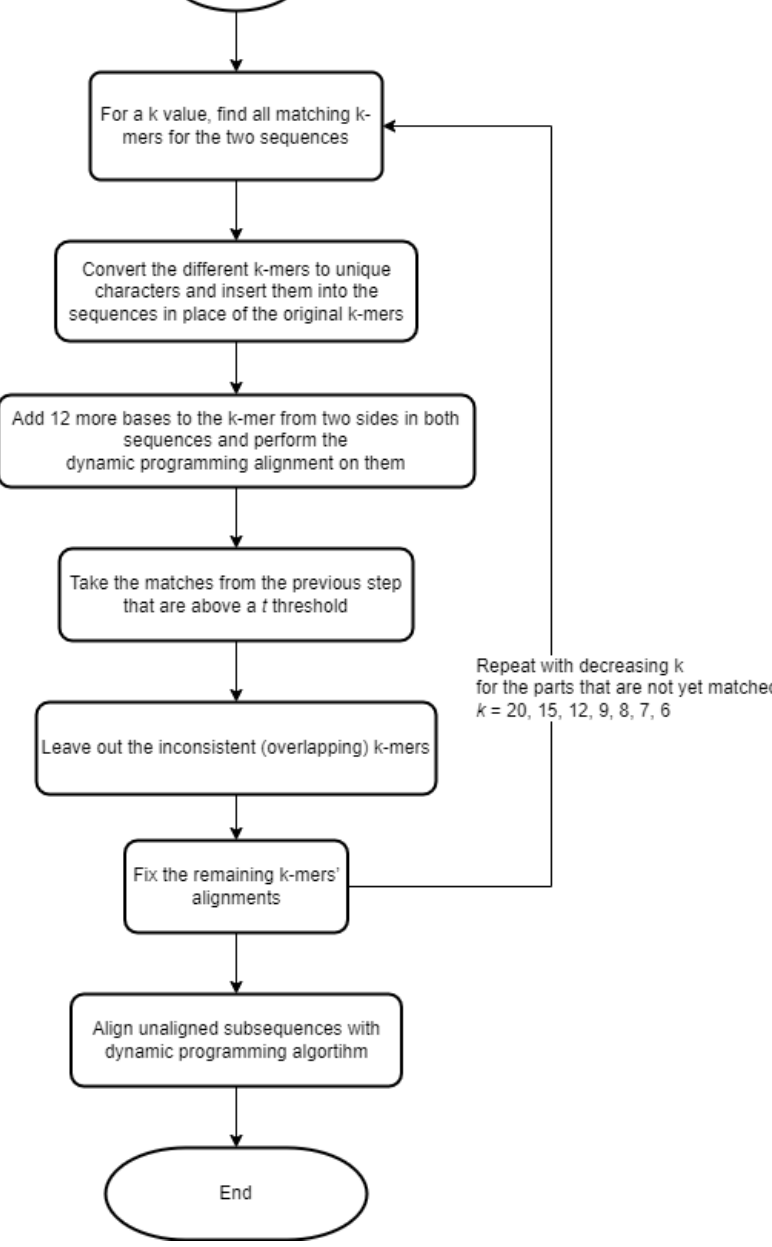
Figure 1. Flowchart of the GLASS